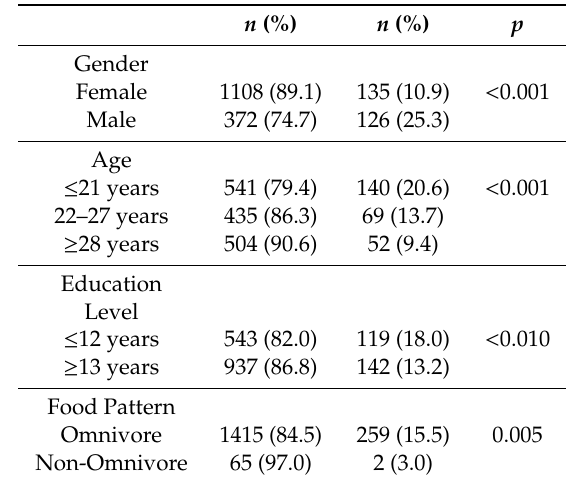
Table 5. Relation between sociodemographic characteristics and motivation to replace animal products with